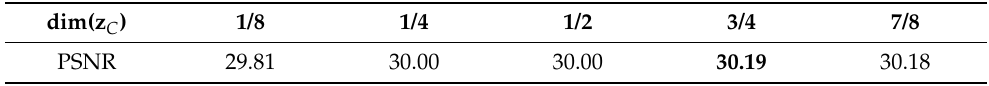
Table 5. Comparisons on different proportions of the dimensions of z C in z